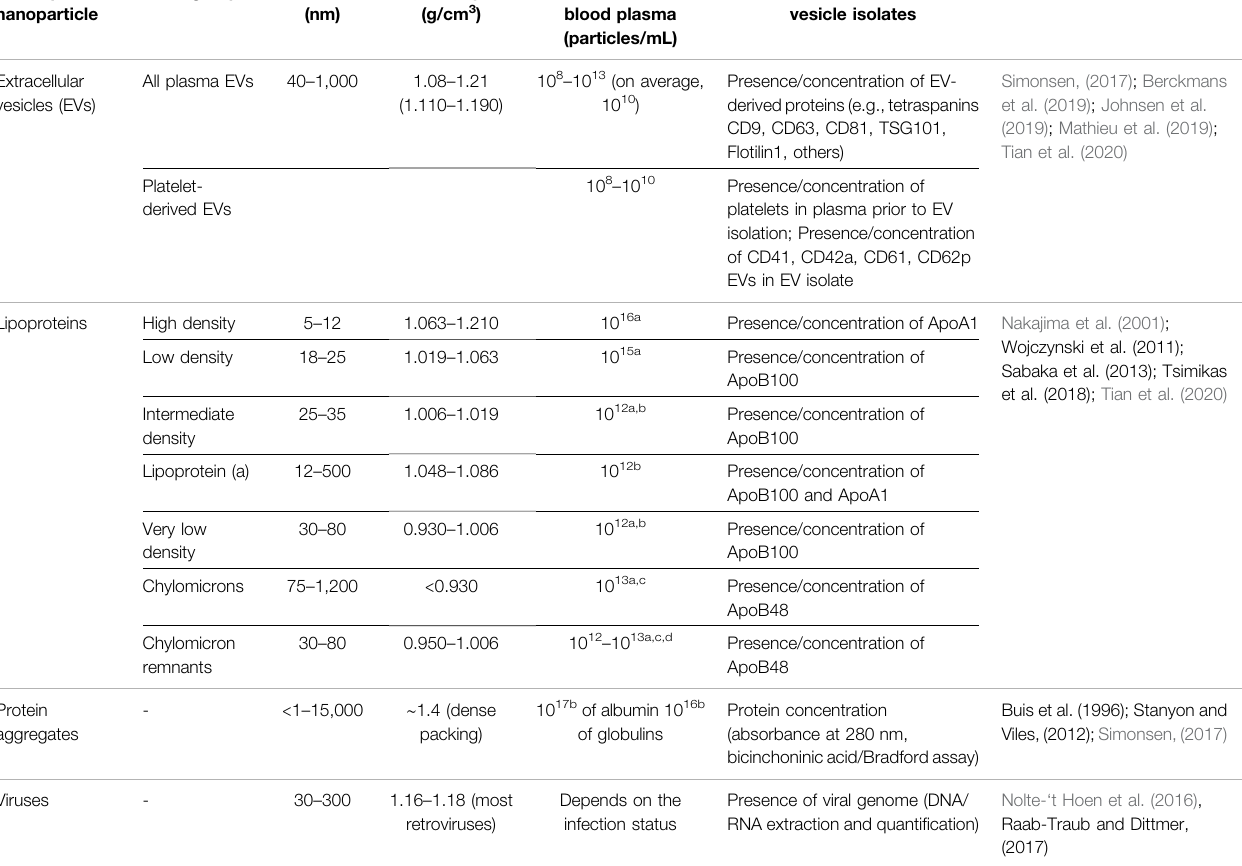
TABLE 1 | Characteristics of blood plasma